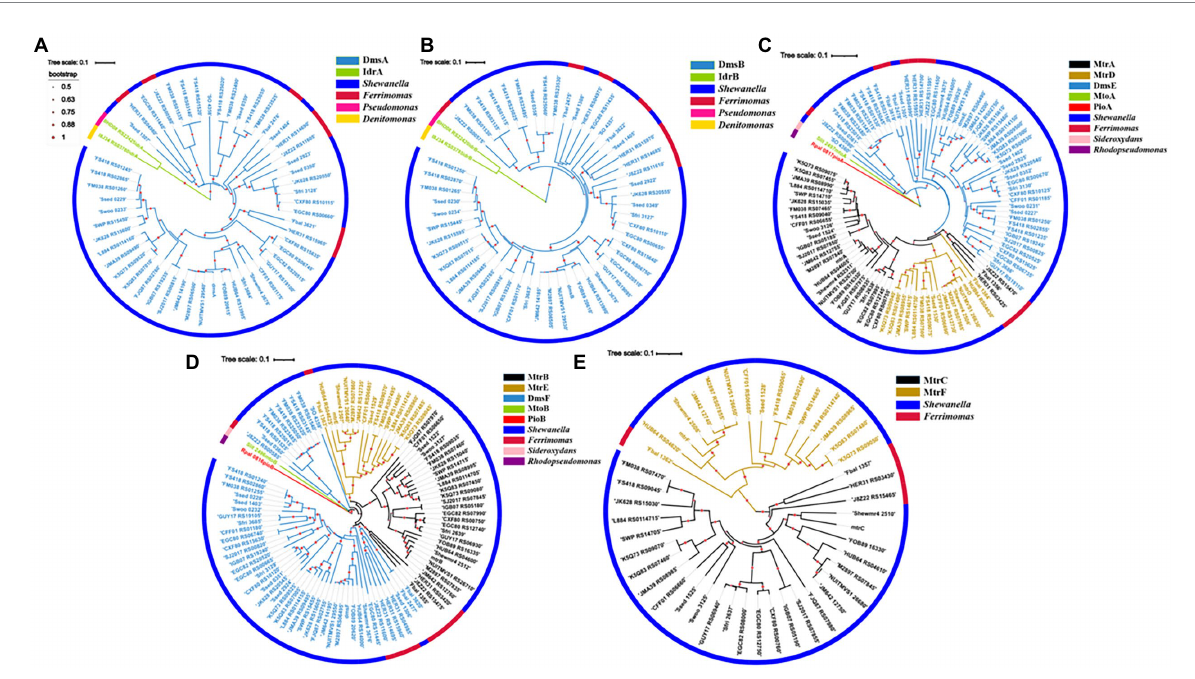
FIGURE 2 Phylogenetic analyses of identified DmsEFAB and MtrCAB homologs. (A) DmsA homologs, (B) DmsB homologs, (C) DmsE/MtrA/MtrD homologs, (D) DmsF/MtrB/MtrE homologs and (E) . MtrC/MtrF homologs. Construction and graphical display of phylogenetic trees were described in text. The outer layer indicates bacterial genera with identified DmsEFAB and MtrCAB homologs. For comparison, IdrAB of Pseudomonas sp. strain SCT and Denitromonas sp. IR-12, MtoAB of Sideroxydans lithotrophicus ES-1, and PioAB of Rhodopseudomonas palustris TIE-1 were included for the